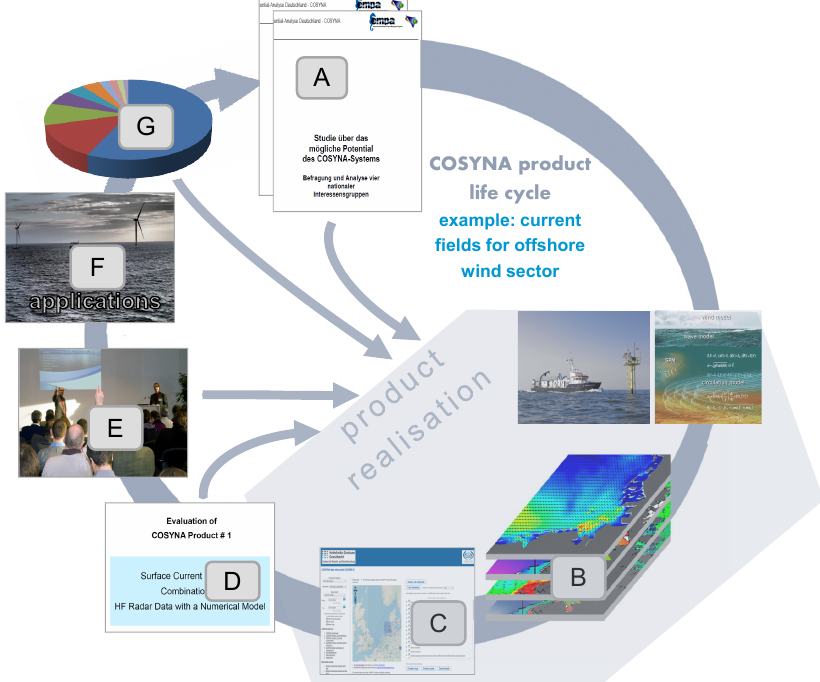
Figure 2. COSYNA product life cycle depicted for the COSYNA product “Surface Current Fields in the German Bight” as an example: (a) initial surveys reveal COSYNA’s potential relevance, (b) the technological and mathematical realization provides optimized parameter fields for currents, waves, temperature, etc., (c) the data are freely accessible via the COSYNA data portal, (d) external evaluation of COSYNA products, (e) interviews and workshops with stakeholders from the offshore wind sector, (f) improved COSYNA products are available to users, (g) evaluation of